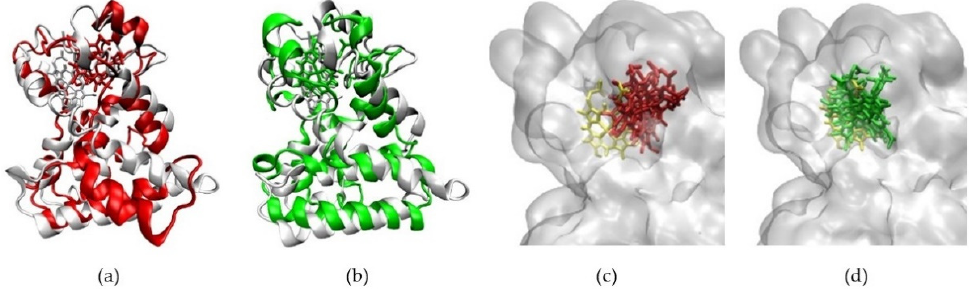
Figure 8. ( a ) The changes in conformation of Agonist-REV-ERB β (red) when forming a complex with CoPP compared with the initial simulation pose (white). ( b ) The other conformation of Agonist-REV-ERB β (green) when forming a complex with Heme compared with the initial simulation pose (white). ( c ) Graph of RMSD values of CoPP (red) and Heme (green) in the binding pocket of Agonist-REV-ERB β during molecular dynamics simulations. ( d ) CoPP and Heme conformations at the end of the simulations.